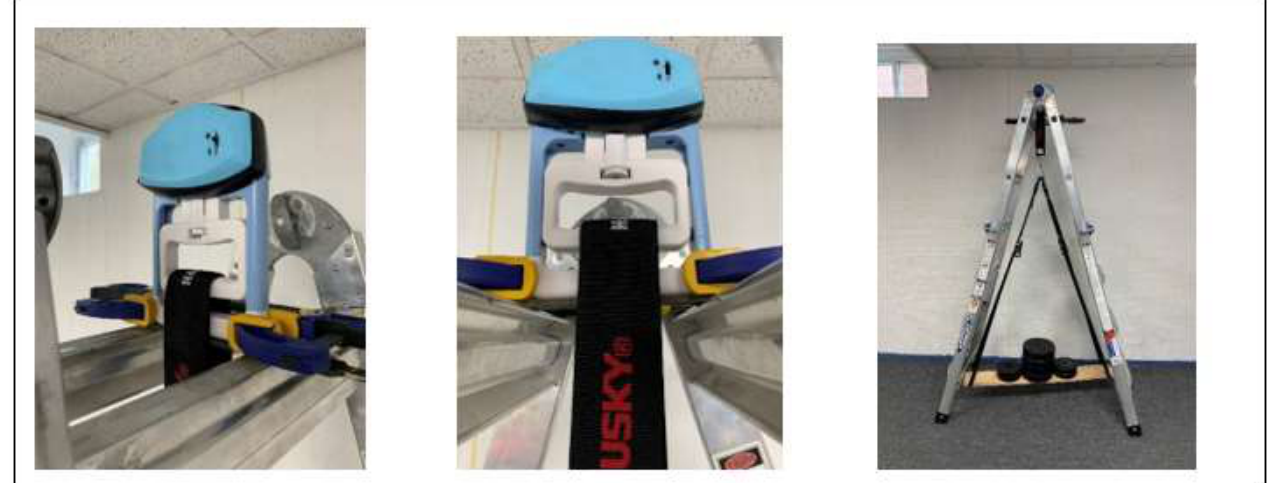
Experimental Setup for Calibrating the